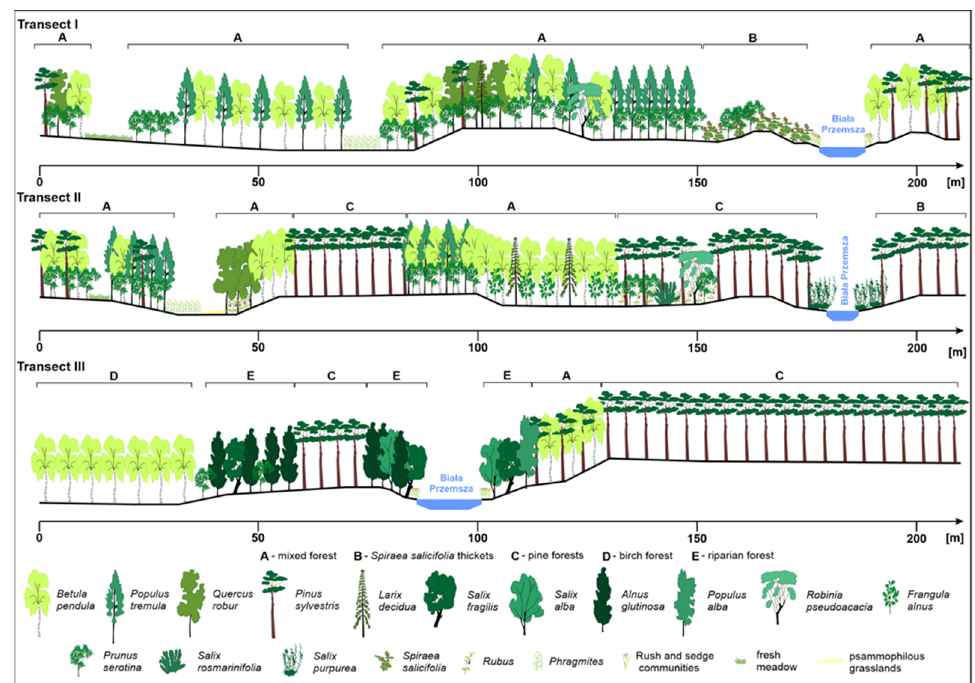
Figure 5. A scheme of the distribution of vegetation in the landscape profile starting from the old riverbed through various anthropogenic forms to the regulated riverbed or beyond.